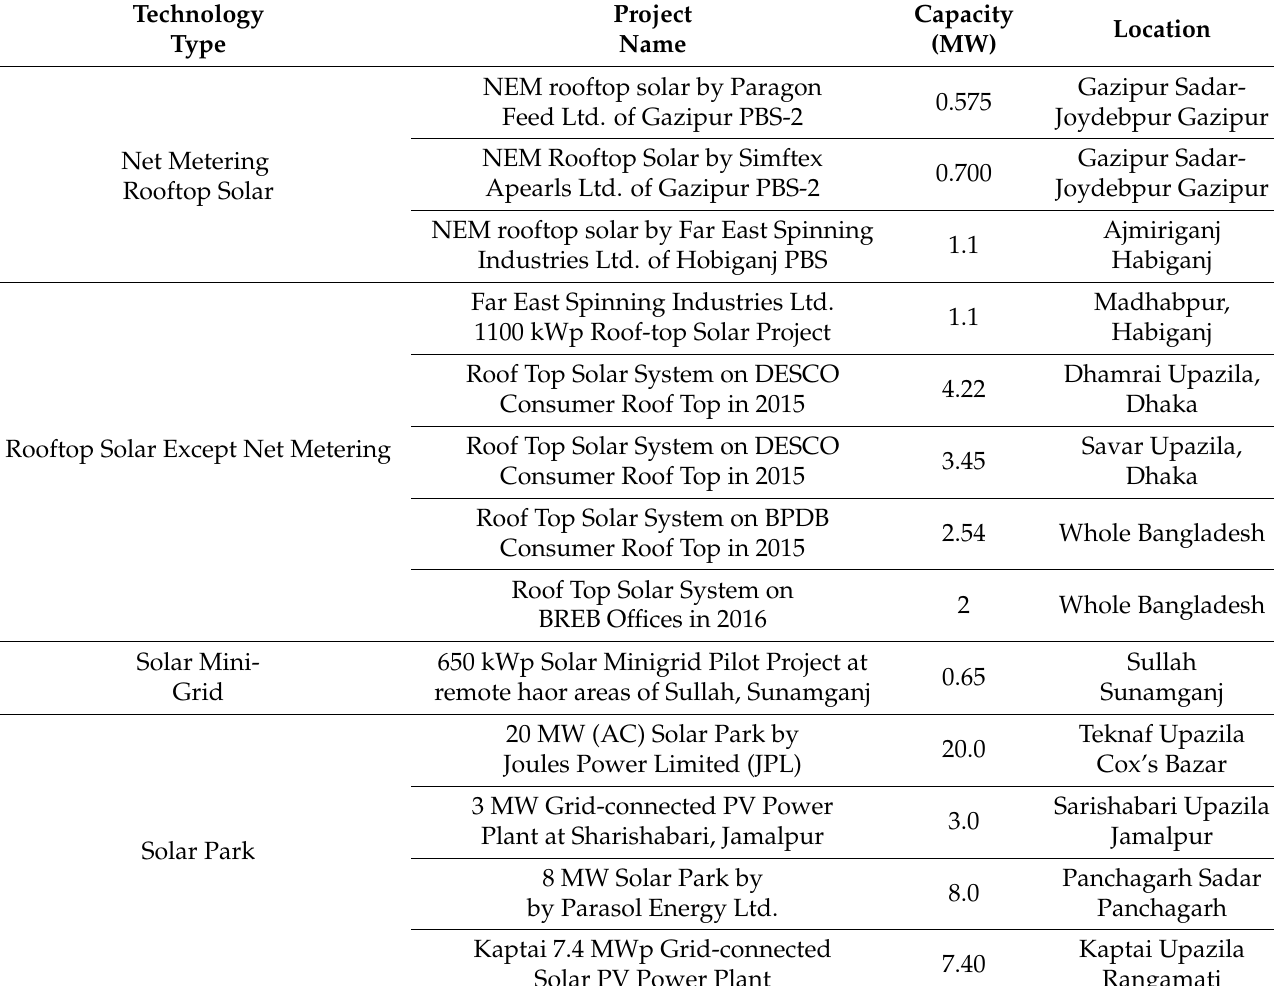
Table 3. Solar projects of Bangladesh